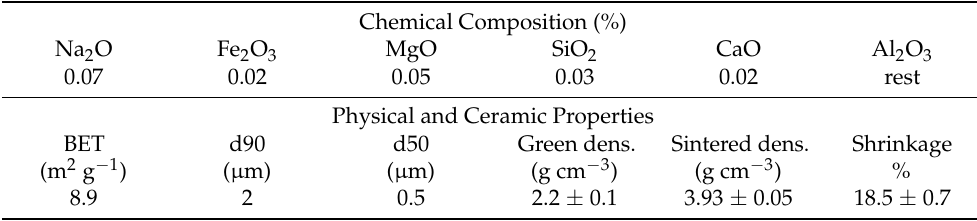
Table 1. The properties of the alumina powder provided by the